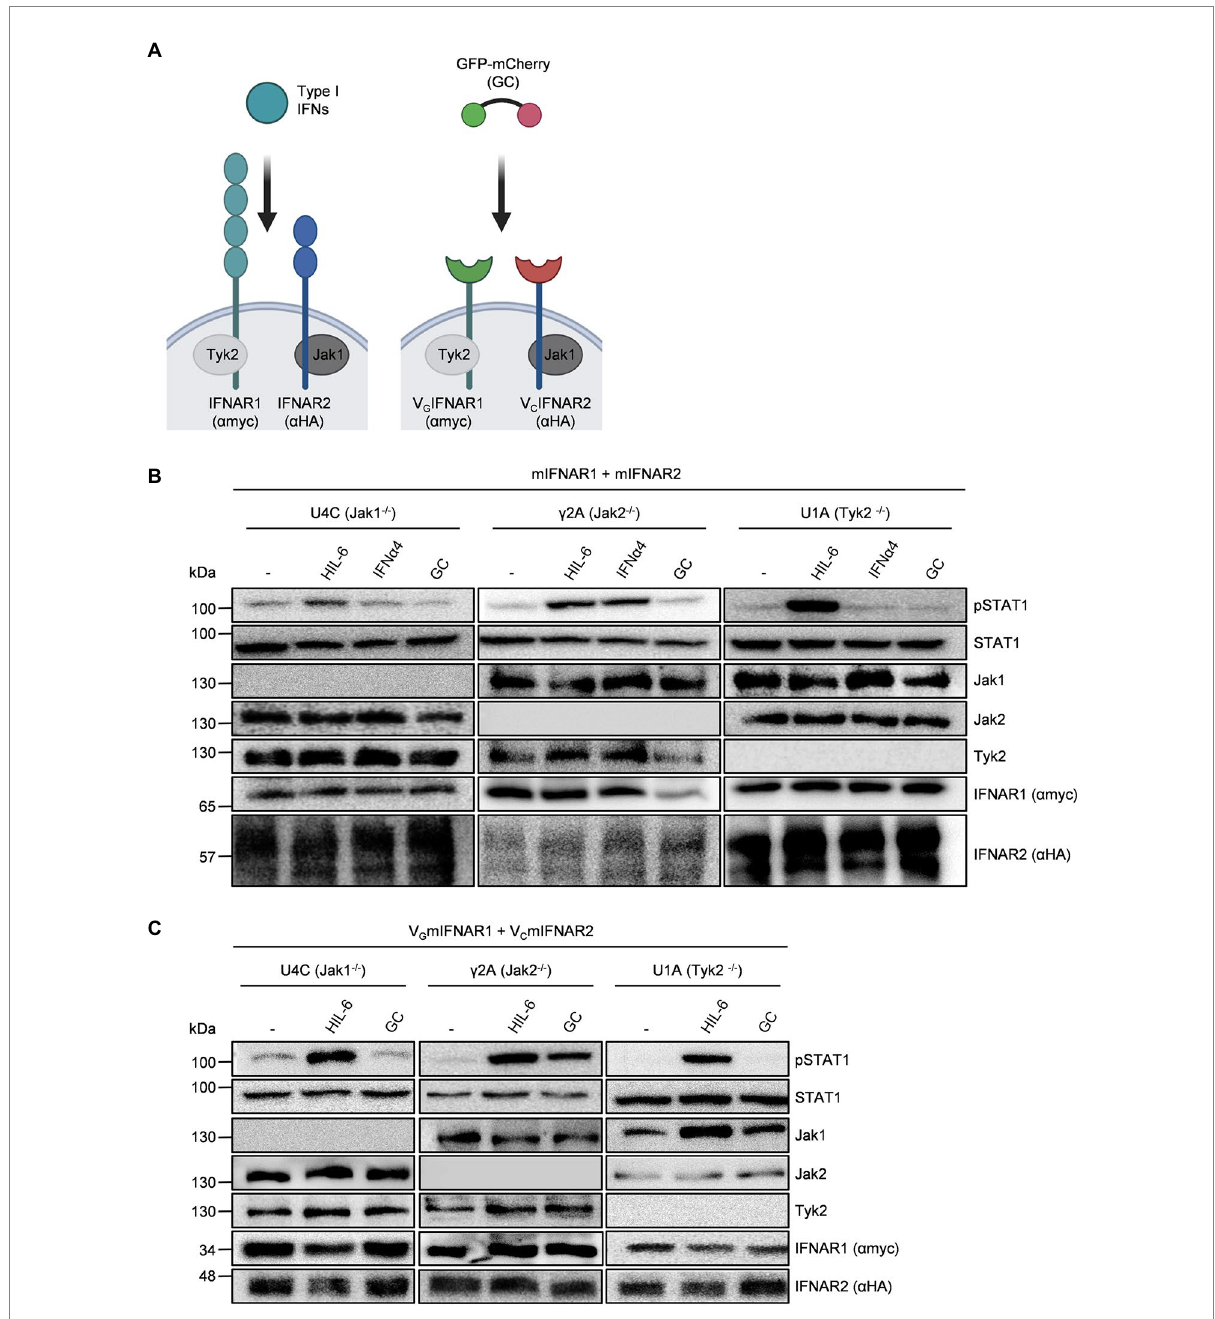
FIGURE 1 Native and synthetic type I IFN signaling depends on Jak1 and Tyk2. (A) Schematic overview of native and synthetic type I IFN signaling. Type I IFN signal via IFNAR1 (myc-tagged, lagoon) and IFNAR2 (HA tagged, blue) which are associated with Tyk2 and Jak1, respectively. In the synthetic receptors, the extracellular domains of IFNAR1 and IFNAR2 were replaced by nanobodies directed against GFP (green) and mCherry (red), respectively. Native IFNARs are activated by type I IFNs, while synthetic IFNARs were activated by dimeric GFP/mCherry ligands (GC). (B) STAT1 activation in U4C (Jak1 − / − ), γ 2A (Jak2 − / − ) and U1A (Tyk2 − / − ) cells transiently expressing murine IFNAR1 and IFNAR2 treated with 200 U/ml IFN α 4, 10 ng/ml Hyper-IL-6 or 10 ng/ml GC for 20 to 30 min. Equal amounts of proteins (50 μ g/lane) were analyzed via specific antibodies detecting phospho-STAT1 and STAT1, Jak1, Jak2, Tyk2, IFNAR1 (myc-tagged), and IFNAR2 (HA-tagged). Western blot data shows one representative experiment out of three. (C) STAT1 activation in U4C (Jak1 − / − ), γ 2A (Jak2 − / − ), and U1A (Tyk2 − / − ) cells transiently expressing murine V G IFNAR1 and V C IFNAR2 treated with 200 U/ml IFN α 4, 10 ng/ml Hyper-IL-6 or 10 ng/ml GC for 20 to 30 min. Equal amounts of proteins (50 μ g/lane) were analyzed via specific antibodies detecting phospho-STAT1 and STAT1, Jak1, Jak2, Tyk2, IFNAR1 (myc-tagged), and IFNAR2 (HA-tagged). Western blot data shows one representative experiment out of